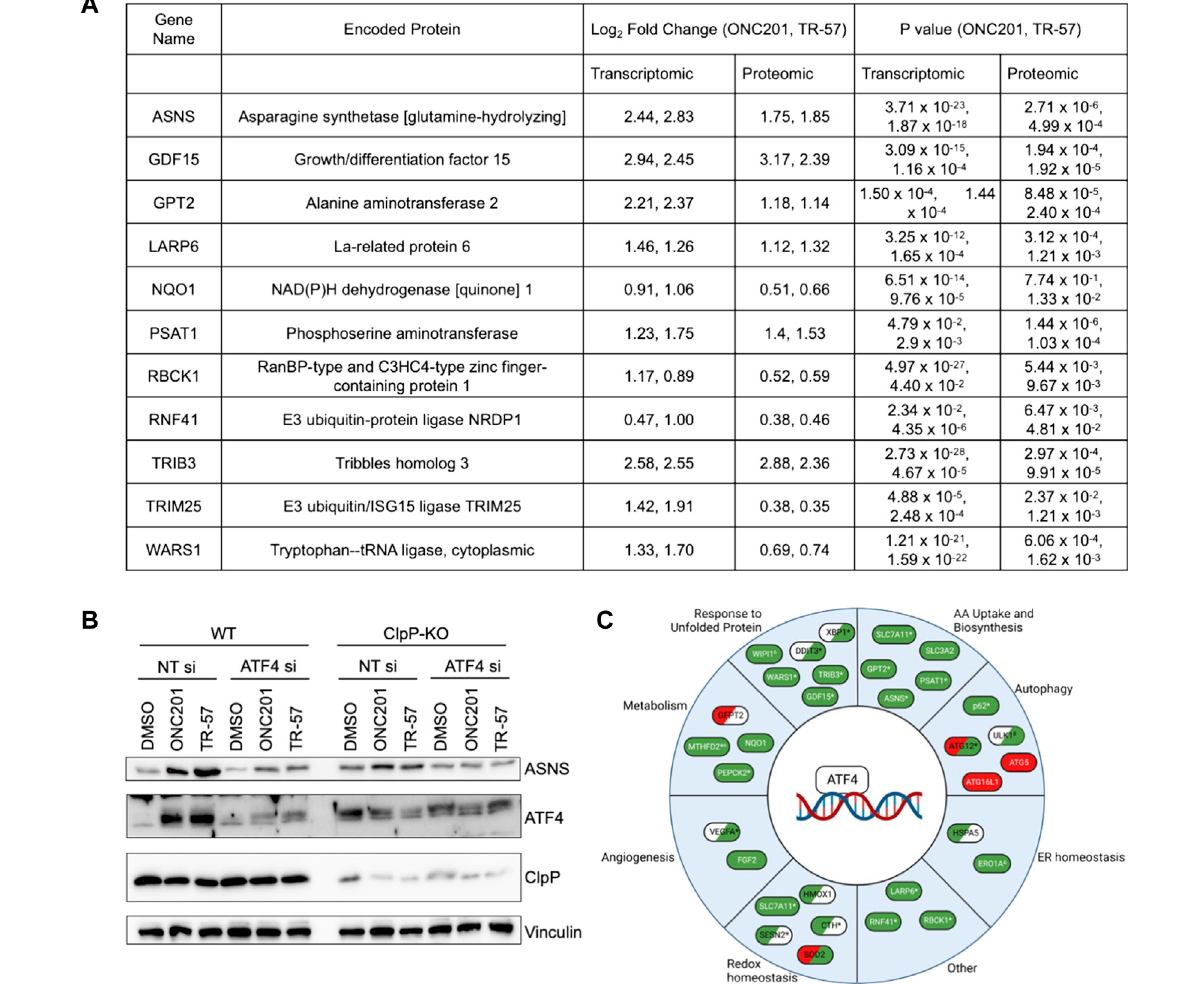
dehydrogenase (PHGDH), and PSAT1 at both the proteomic